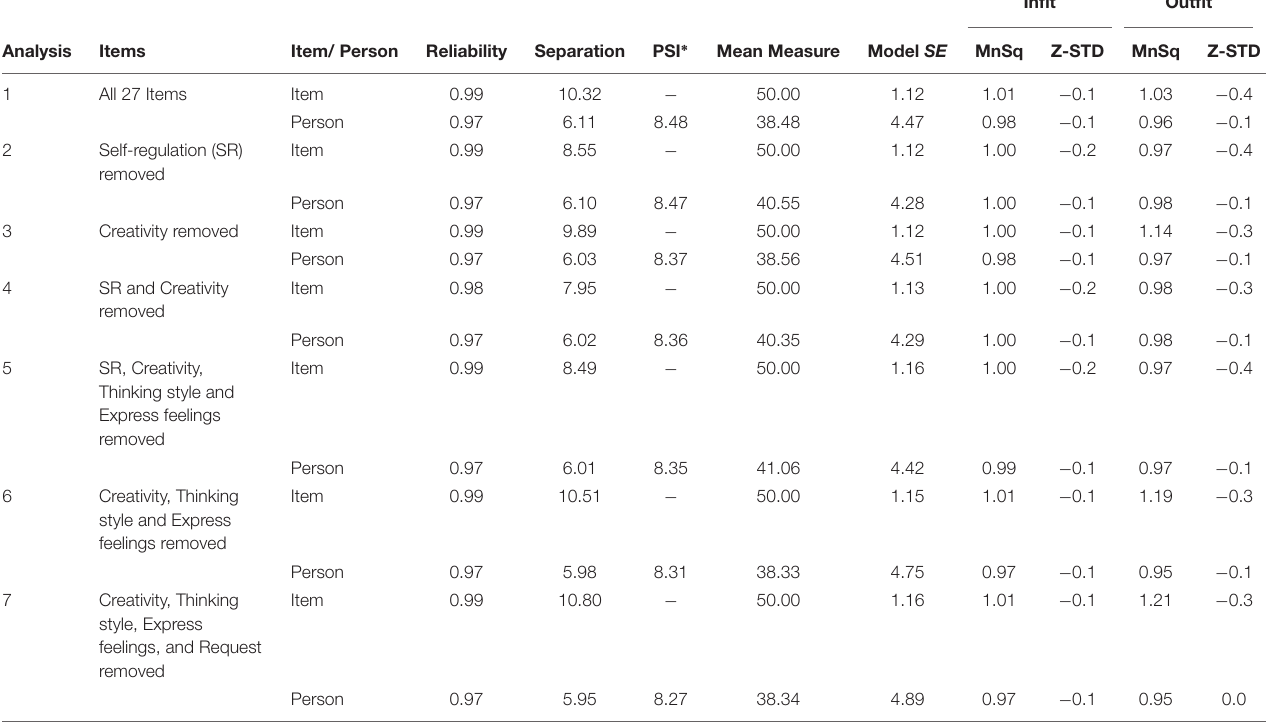
TABLE 4 | Item and person summary